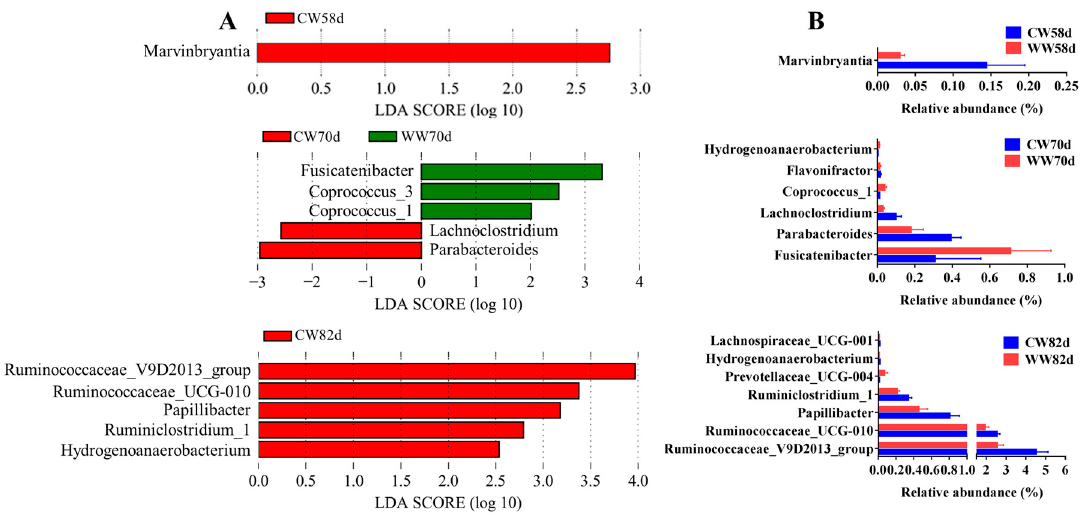
Figure 5. Alteration of the microbial genera among the different groups ( n = 9–15). ( A ) Genera that are differentially represented between the groups drinking warm and cold water identified by LEfSe (linear discriminant analysis score > 2, p < 0.05). ( B ) Significantly different genera among the different groups are shown, based on p < 0.05 by the Wilcoxon rank-sum test. CW, cold water group; WW, warm water group.